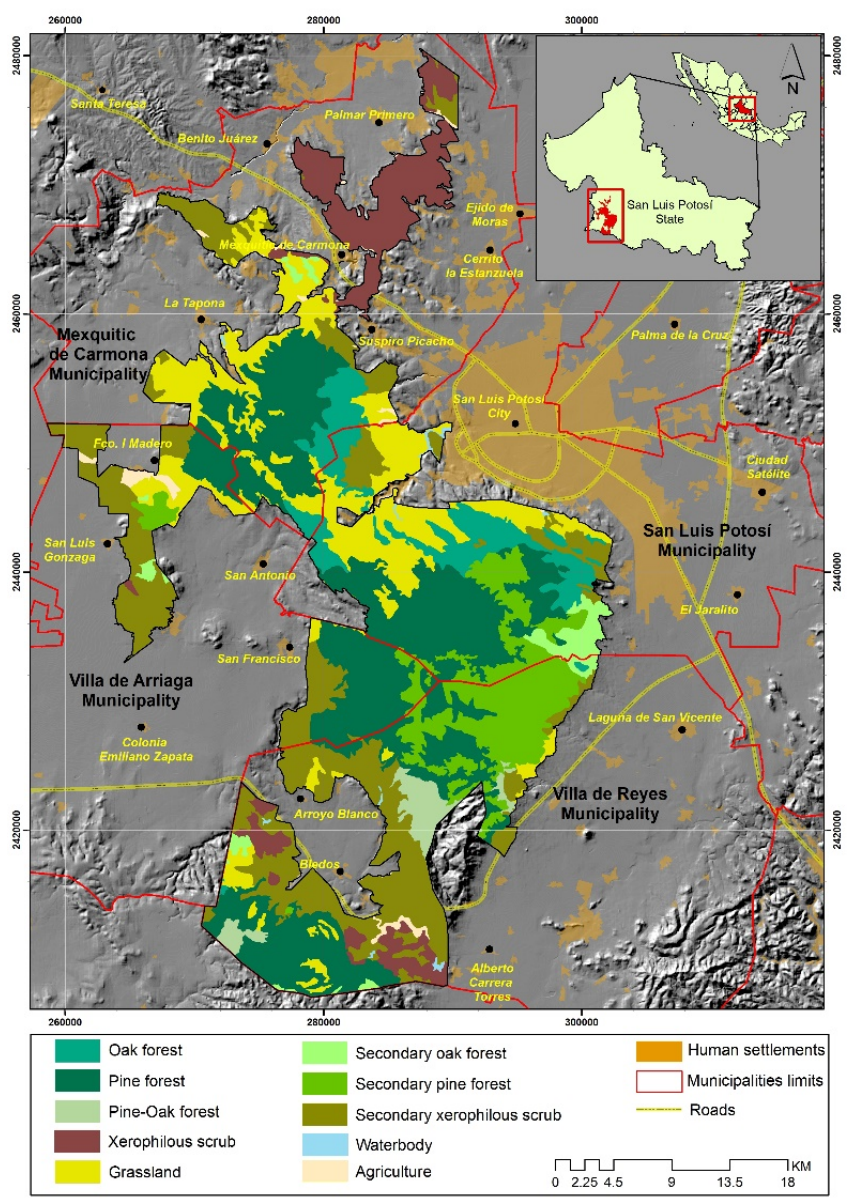
Figure 2. Vegetation types in the study area, in 2020.